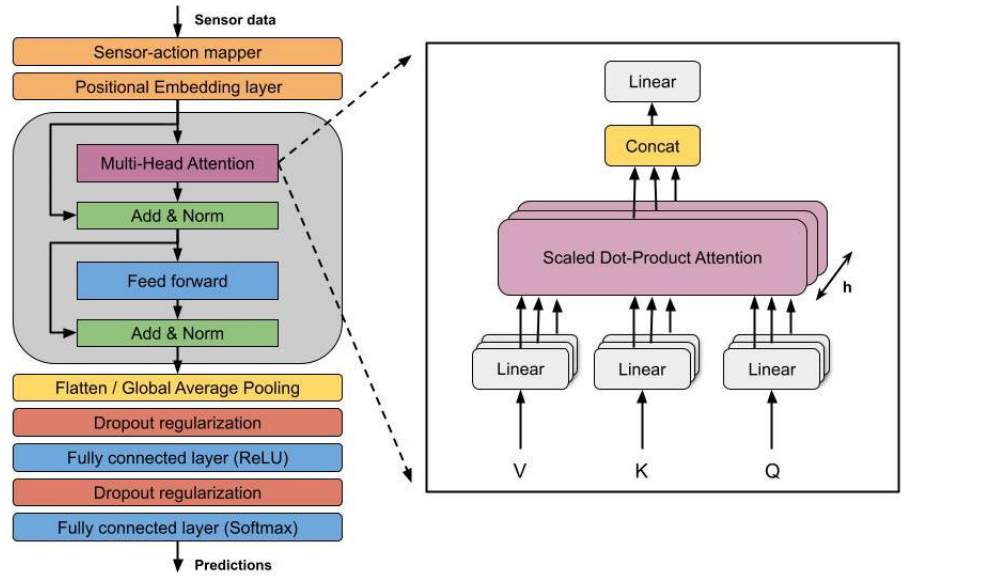
Figure 1. Transformer architecture for behavior